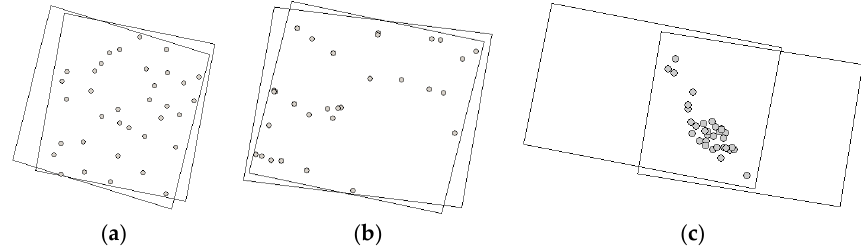
Figure 6. Distribution of GCPs throughout the stereo imagery: ( a ) Isfahan dataset; ( b ) Zanjan dataset; ( c ) Fars dataset.